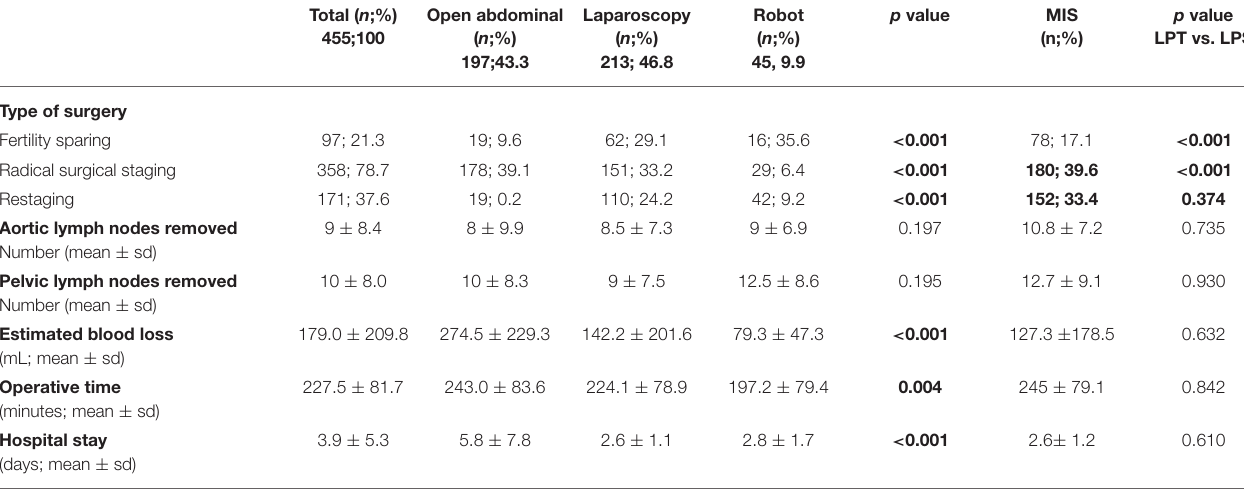
TABLE 4 | Surgical outcomes.